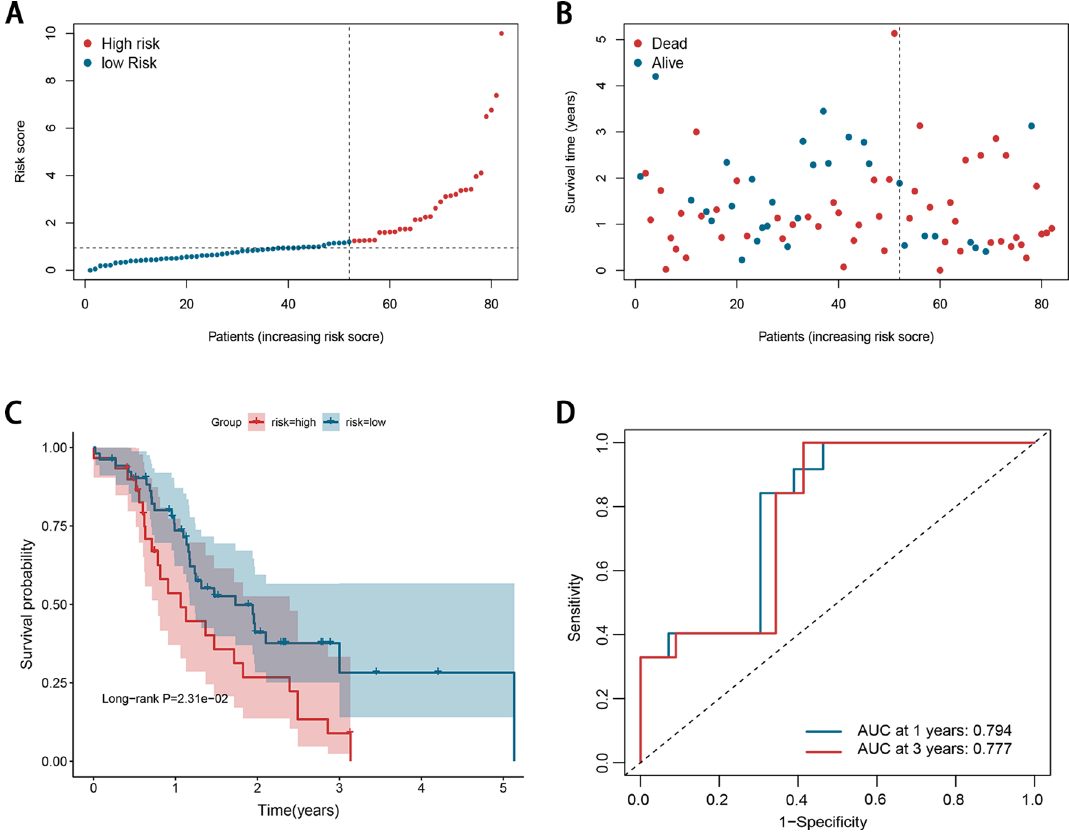
Figure 2. Evaluation of the signature in the ICGC dataset. ( A ) The distribution of the risk scores. ( B ) Scatter plot illustrating the patients’ survival status. ( C ) Kaplan–Meier survival estimates of OS according to the signature. ( D ) The 1- and 3-year ROC curves of the signature in predicting OS of PDAC